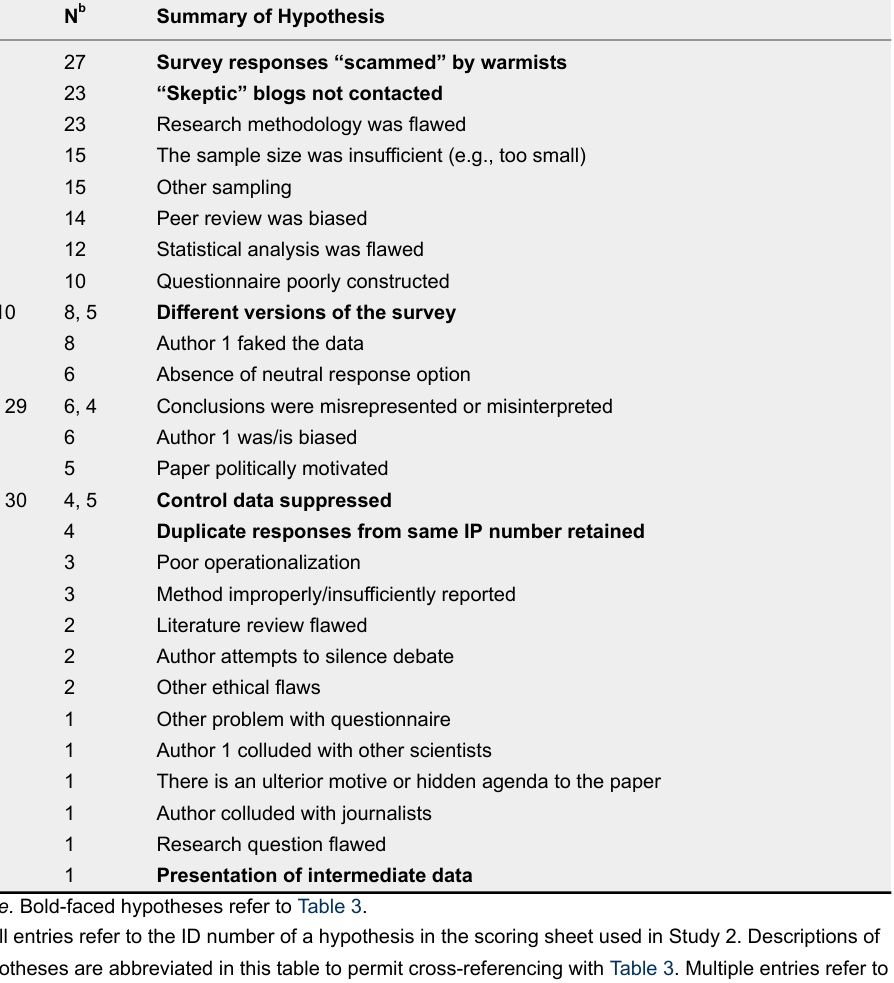
Frequency of Classification of Comments from the “Breadth” Search by Participants in Study